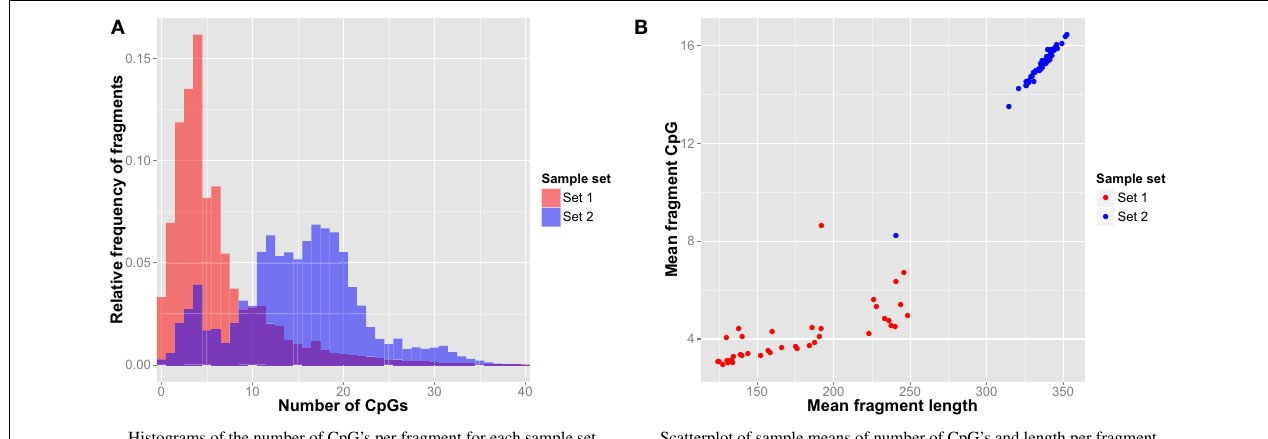
FIGURE 1 | Fragment CpG content. (A) Histogram of CpG content per sample set. (B) Relation of CpG content and length per sample.